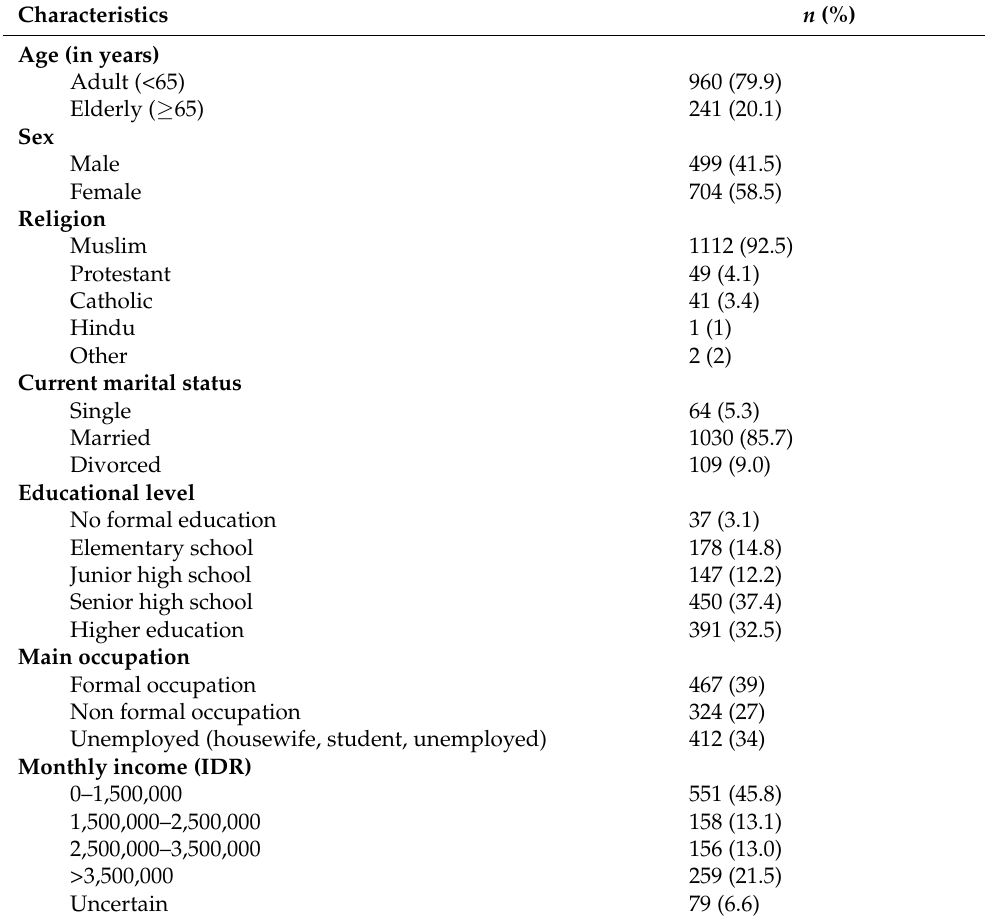
Table 2. Socio-demographic characteristics of participants ( n =